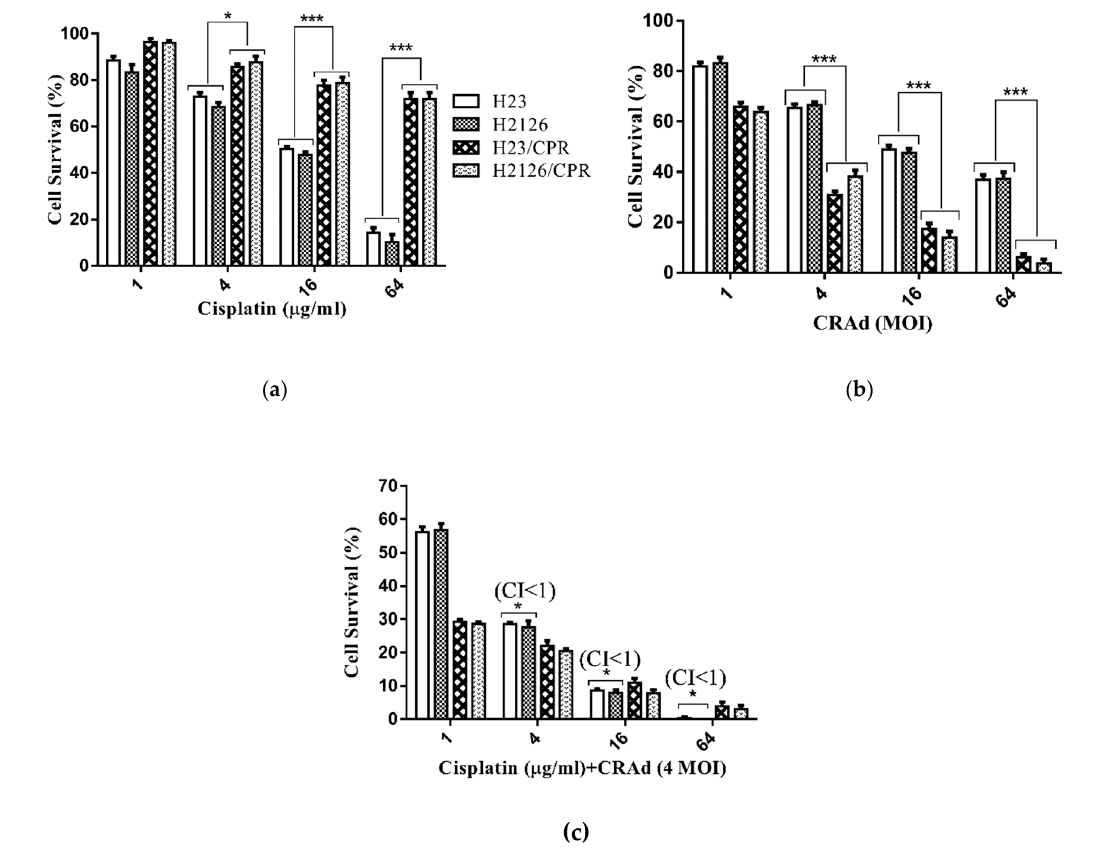
Figure 4. Tumor cell viability analysis. ( a ) Cisplatin decreases the viability of chemo-sensitive lung cancer cell lines, H23 and H2126, in a dose-dependent manner but resistant sublines give a poor response. ( b ) Both lung cancer cell lines were infected with variable MOIs (1–64) of CRAd. Cisplatin-resistant cells exhibit remarkably high tumor inhibition as compared to sensitive cells. ( c ) Co-treatment of cisplatin with CRAd results in very high initial inhibition rate even at a lower dose of cisplatin, and a continuous increase in inhibition was seen with increasing cisplatin doses. Cisplatin-sensitive cells showed a decrease in the cancer cell population in a synergistic manner (CI < 1). To calculate CI values following the Chou–Talalay method, CompuSyn 2.0 software was used. The data shown are the average of triplicate experiments. Data are presented as the mean ± SD in ( a – c ), ( n = 3), * p < 0.05, *** p < 0.001, by two-tailed Student’s t-test.